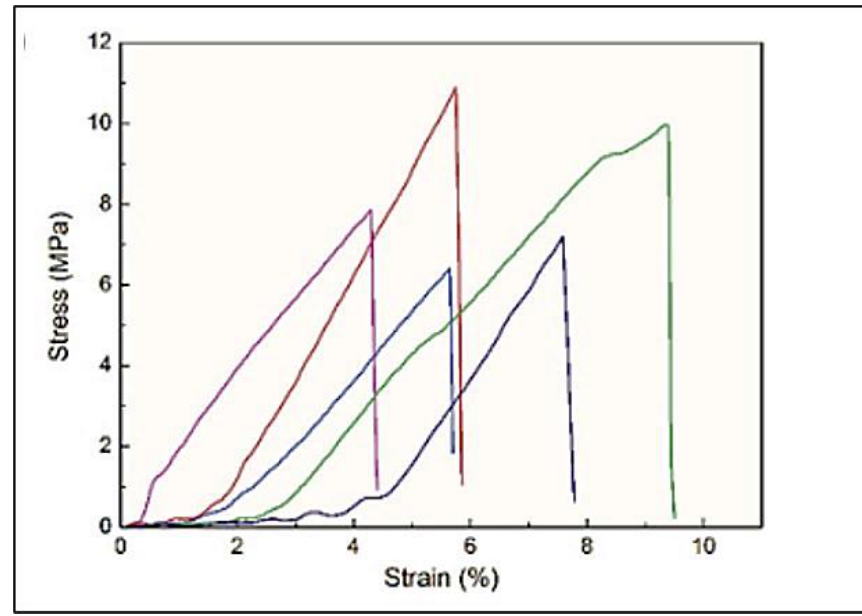
Figure 11. Stress–strain curve of carbon nanofiber mats [1].